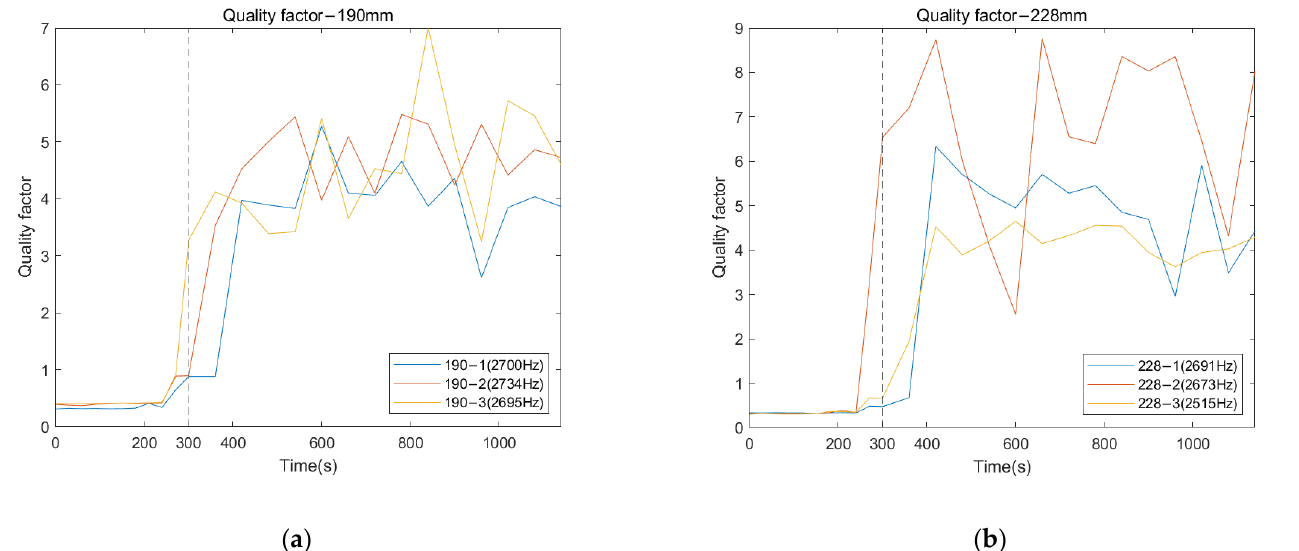
Figure 10. Quality factor of selected resonant peaks as function of time for residual lengths of ( a ) 190 and ( b ) 228 mm.